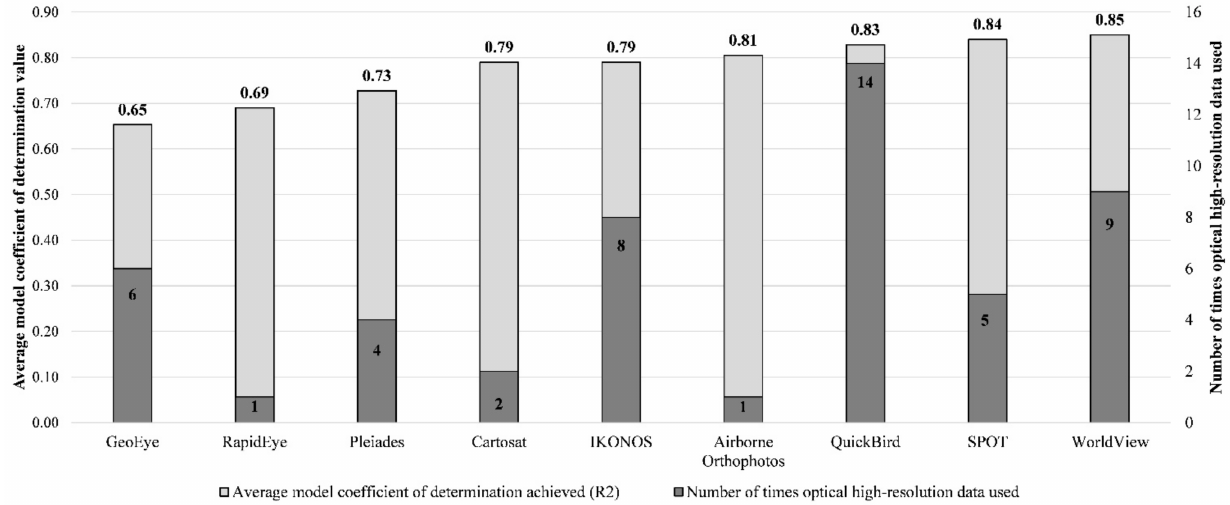
Figure 6. Percentage of studies conducted per sensor vs. average model of coefficient of determination (R 2